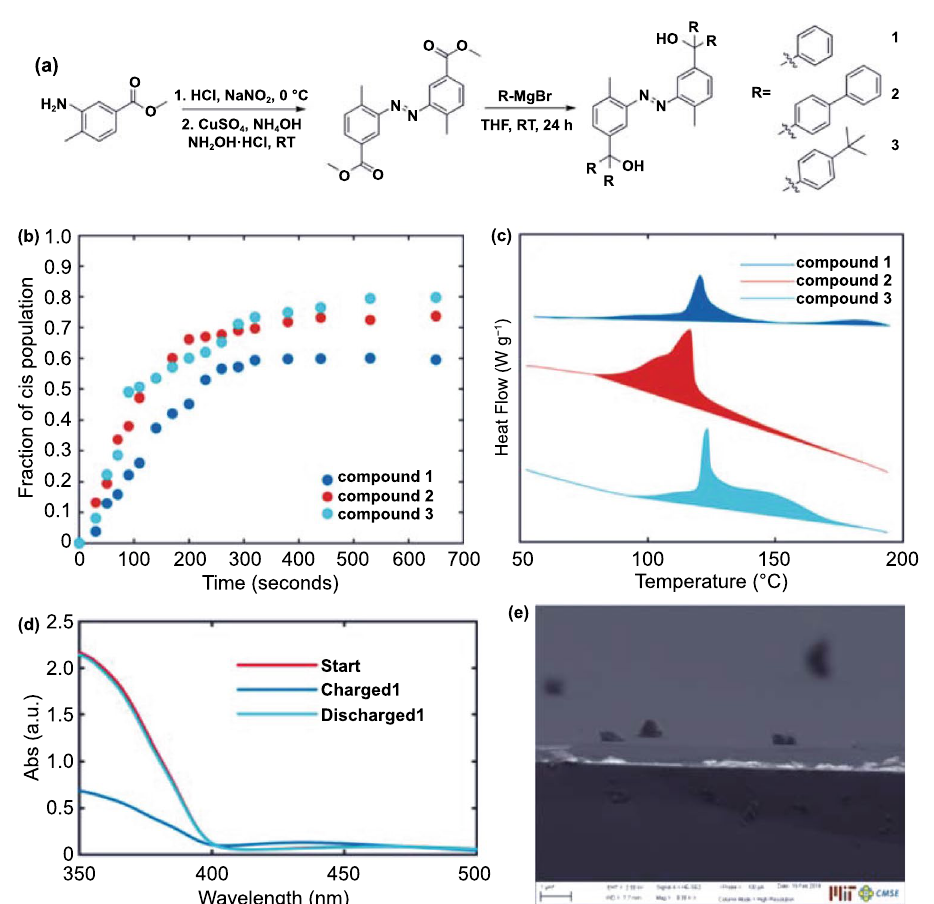
Fig. 6 a Schematic of synthesis of compounds 1–3 via the diazotization of an aniline precursor followed by the addition of different aryl groups using Grignard reagents. b Chargeability of compounds 1, 2, and 3. The process was done ex situ, where the sample was charged under 365 nm UV light for a set time, and then solid-state UV–Vis spectra were obtained. c DSC traces for compounds 1, 2, and 3 from top to bottom. The y-direction represents heat release, and the region enclosed in the flat baseline represents the area integrated to obtain energy release. d UV–Vis spectrum of light charging of compound 3 films and heat discharging from them. e Cross-sectional scanning electron microscopy (SEM) of the compound 3 film [59]